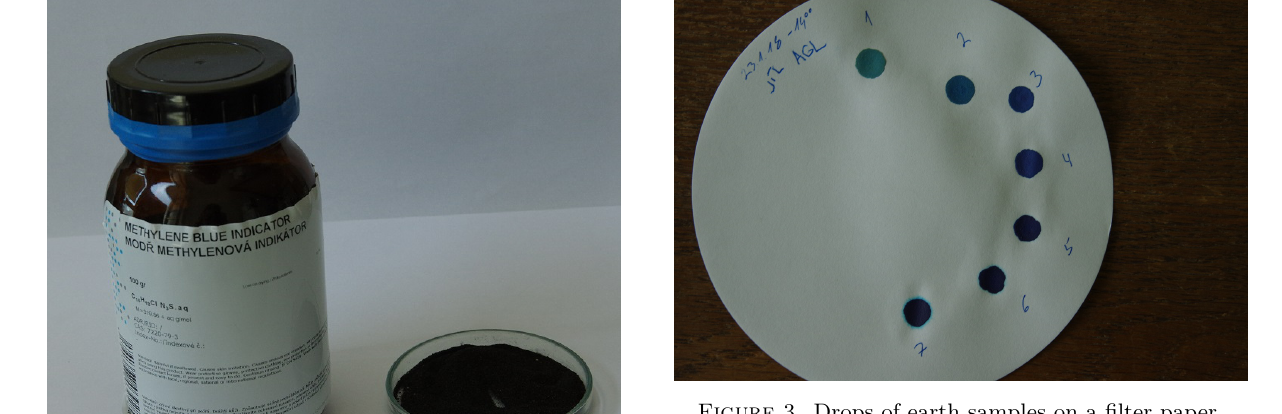
Figure 3. Drops of earth samples on a filter paper.